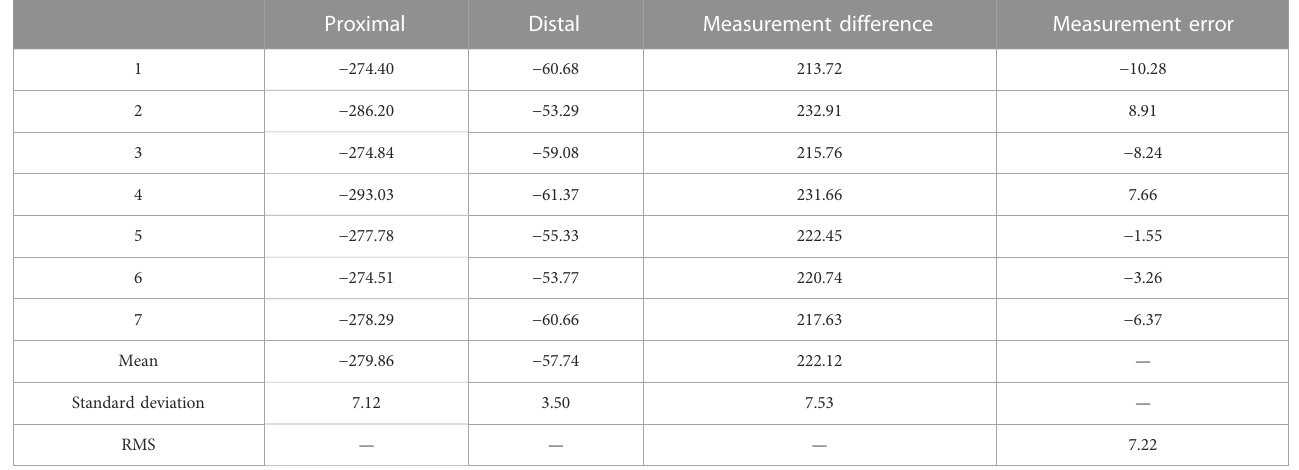
TABLE 1 Statistics of static accuracy test data of GGMS( T uv